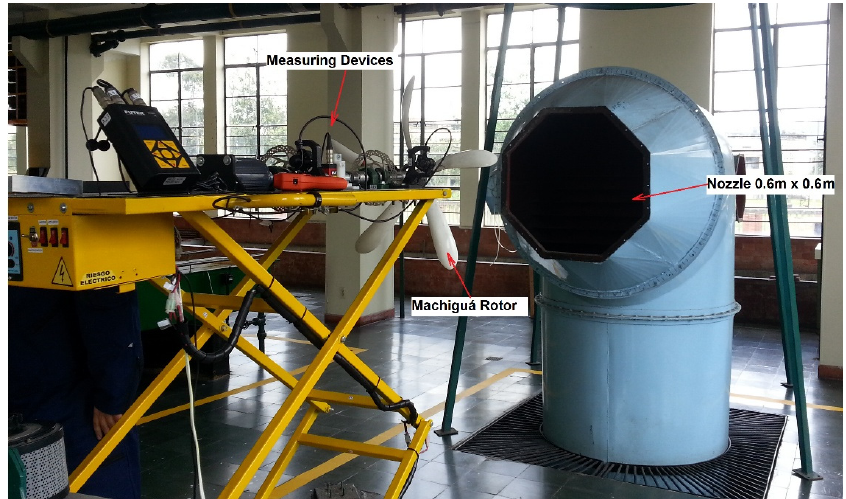
Figure 5. Experiment arrangement.